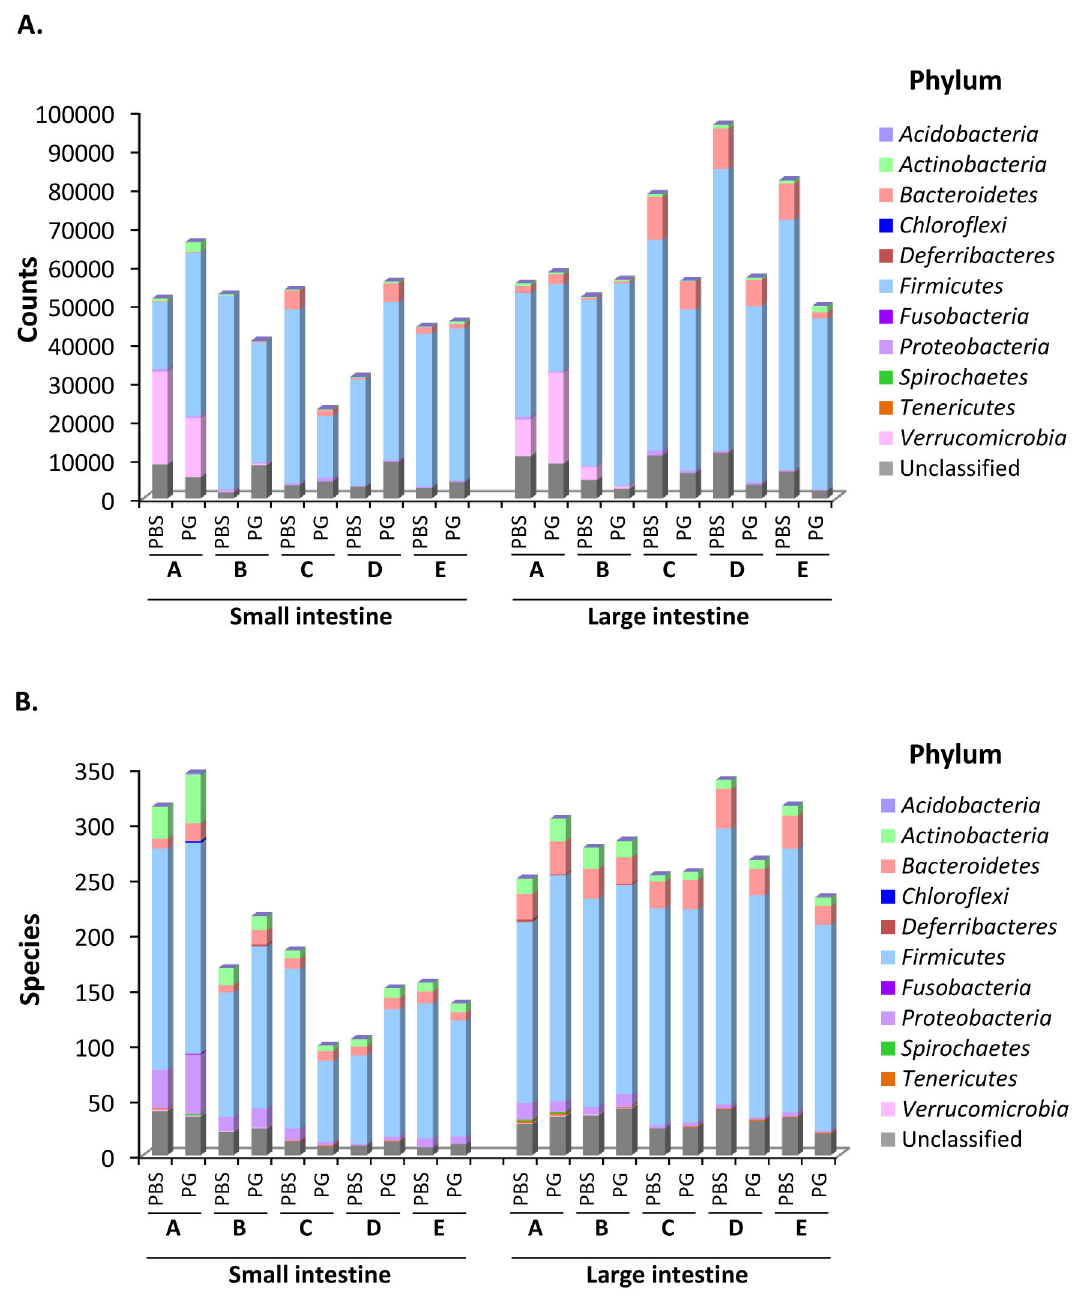
Figure 1. Total counts (A) and number of assigned phylotypes (B) obtained from each intestinal sample. (A) Total counts were obtained after removing the sequences under threshold of 350 nucleotides in length and 85.0% identity. (B) Bacterial phylotypes from each sample were assigned from the closest related 16S rRNA sequence. The number of counts and the number of bacterial phylotypes in each phylum were indicated. Sequences that could not be classified into known phyla were assigned as ‘Unclassified’. A, B, C, D and E indicate the results obtained from group A, group B, group C, group D and group E mice,